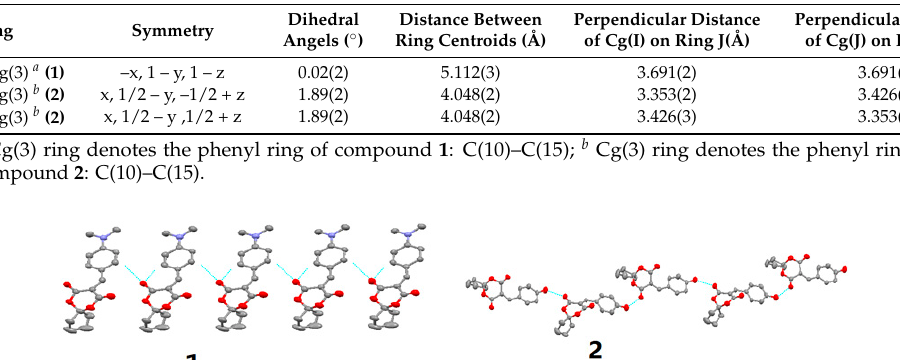
Figure 3. Hydrogen bonds and intermolecular interactions of 1 and 2.